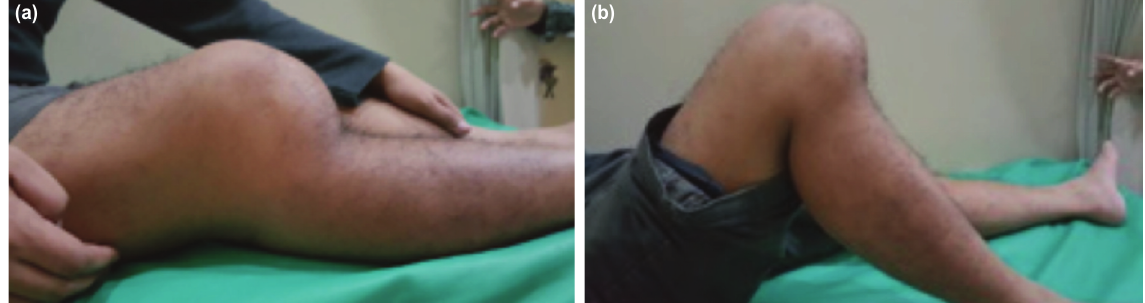
Clinical presentation, (a) maximal extension, (b) maximal flexion. Fig. 1: